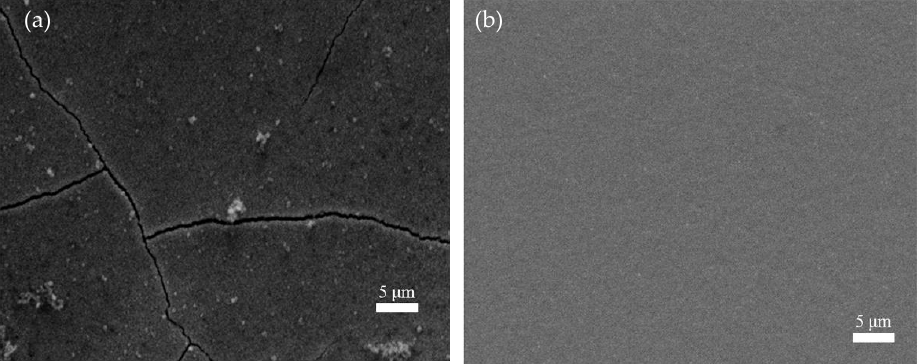
Figure 9. The effect of saccharin sodium on the surface morphology. ( a ) without saccharin sodium, ( b ) with saccharin sodium.